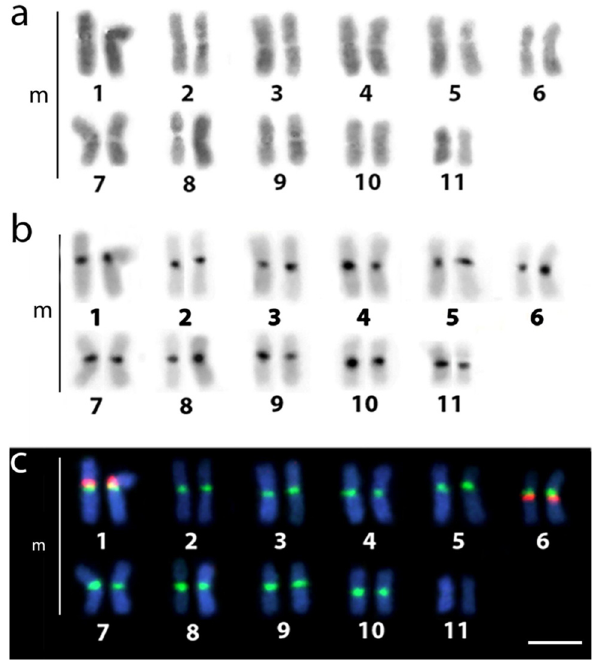
Figure 2. Karyotypes of N. anduzei subjected to sequential Giemsa staining ( a ), C-banding ( b ), and FISH ( c ) with 5S (red) and 18S (green) rDNA probes. Scale Bar = 10 µ m. Chromosome mapping with the (CA)n, (GA)n, and (CGG)n microsatellite probes displayed a similar pattern for males and females. The microsatellites (CA)n and